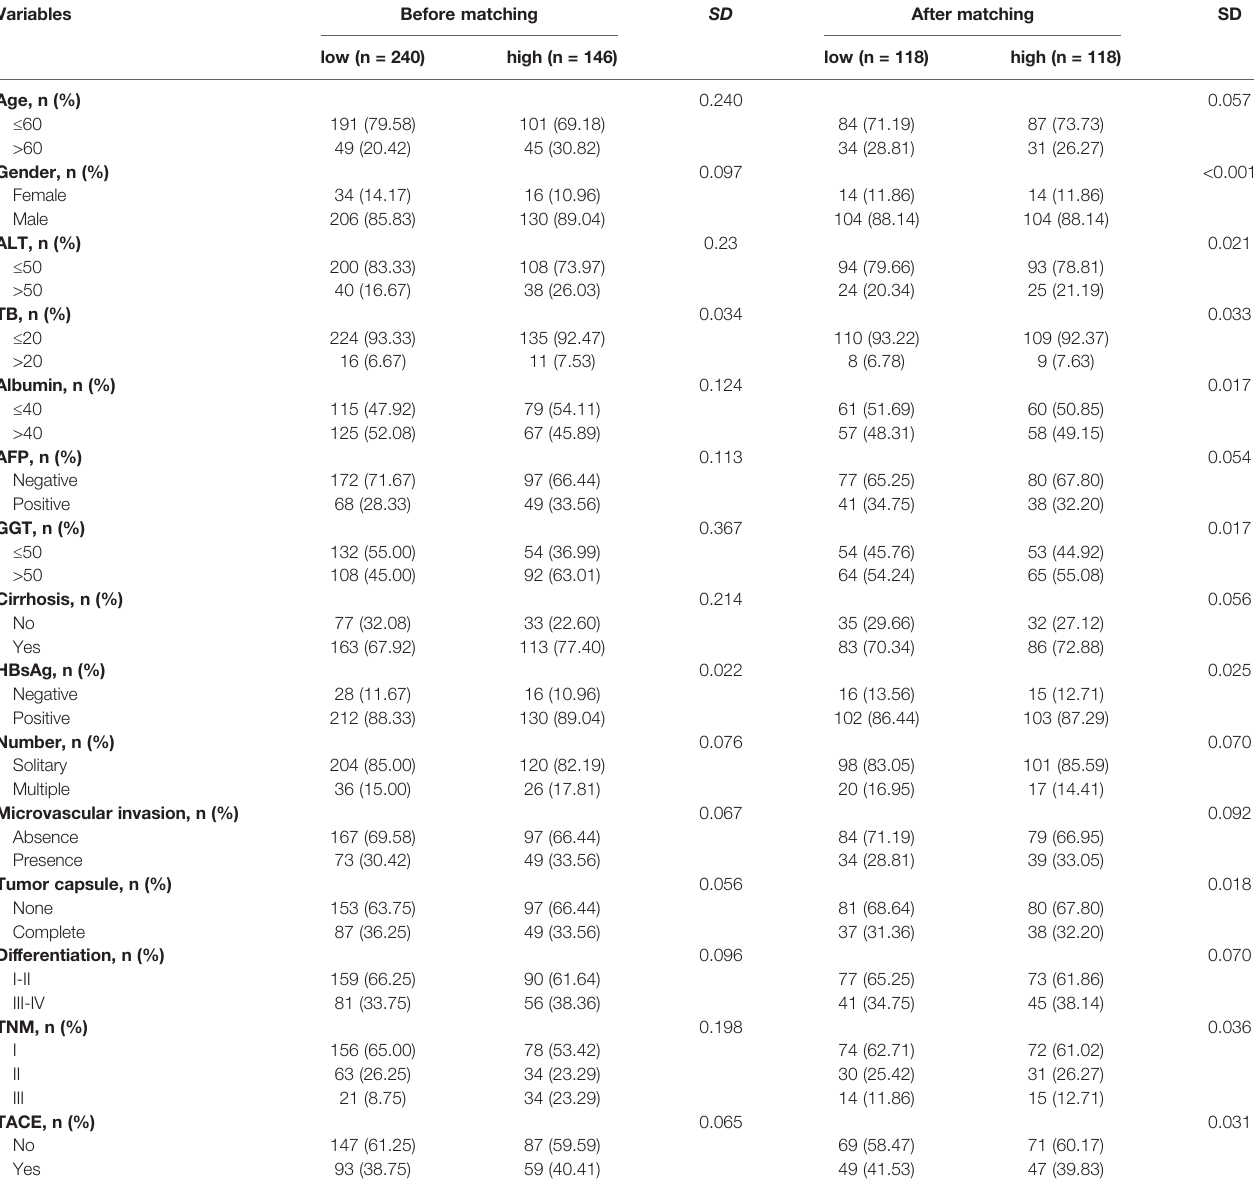
TABLE 3 | The distribution of clinicopathological variables with standardized difference before and after propensity score matching. Variables Before matching SD After